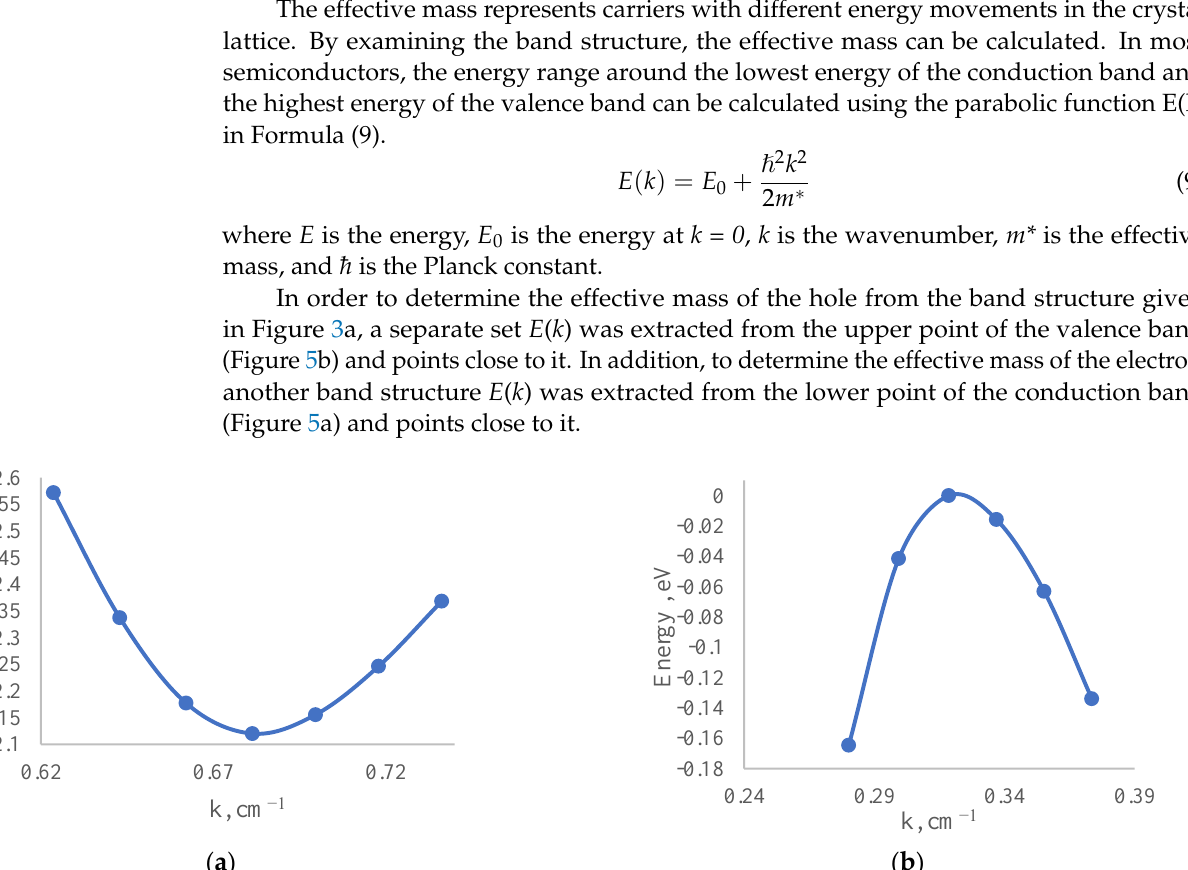
Figure 4. Density of States of MoO 3 calculated using PBE and HSE06.